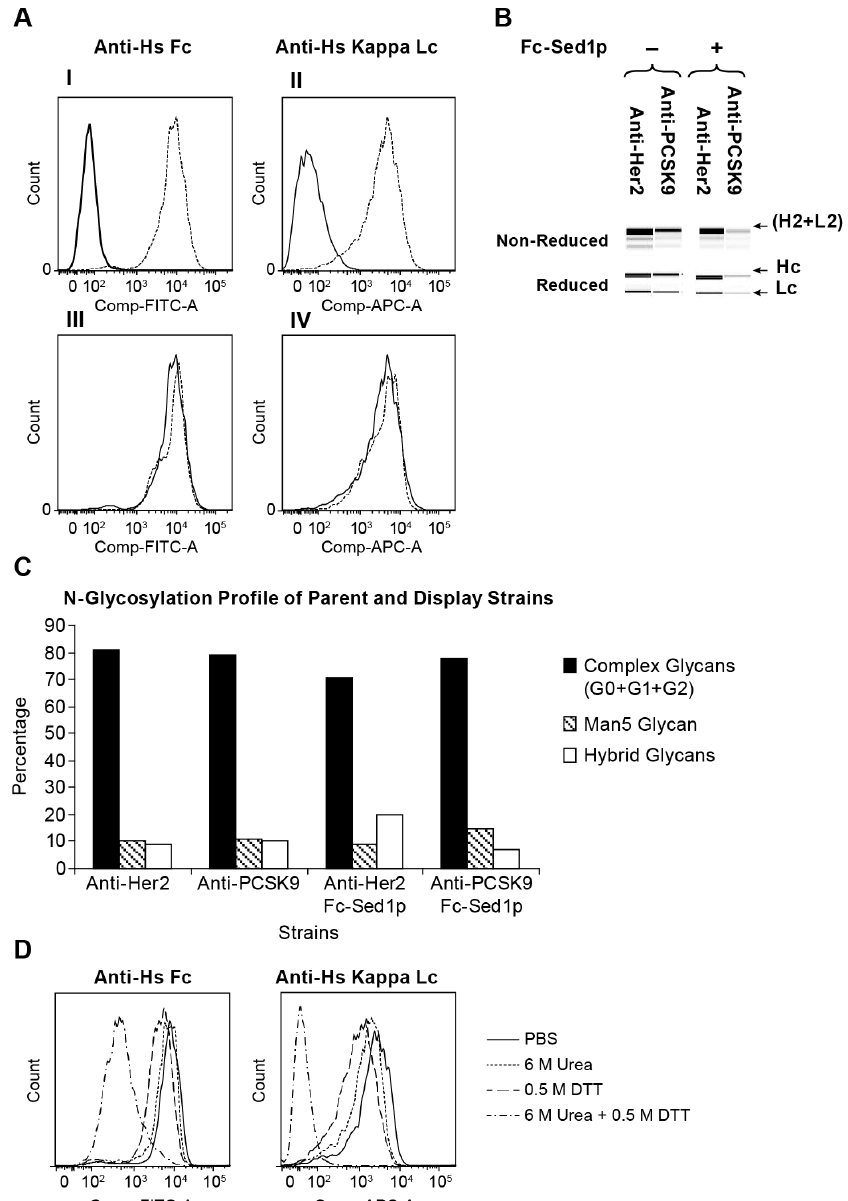
Figure 2. Efficiency of the surface anchored Fc bait (Fc-Sed1p) in capturing monovalent IgG molecules on the cell wall of Glyco-engineered Pichia pastoris . A ) (I) Strain expressing soluble anti-PCSK9 antibody (solid histogram) and anti-PCSK9 strain co-expressing Fc-Sed1p fusion (dotted) were incubated with DyeLight 488 anti-Fc antibody and florescence intensities were assayed by flow cytometry (II). Same strains as in (I) were incubated with APC-conjugated anti-Kappa antibodies to detect light chain on cell surface (III). Flow cytometry was used to compare strain co-expressing anti-PCSK9 and Fc-Sed1p anchor (solid) against strain co-expressing anti-Her2 and Fc-Sed1p (dotted) for binding to DyeLight 488 anti-Fc or (IV) APC-anti Kappa. B ) Detection of co-secreted full length IgG in antibody producing strains with and without Fc-Sed1p. Culture medium was passed through a protein A column, IgGs were eluted and protein was resolved in a native or reduced form through Protein Chip analysis C ) Bar graph of percentage human N-glycosylation abundances of protein A purified mAbs isolated in B. D) Cells co-expressing anti- PCSK9 and Fc-Sed1p fusion were induced and incubated for 10 minutes at room temperature in 1XPBS buffer (solid); 1XPBS buffer containing 6 M Urea (dotted); 1XPBS buffer containing 0.5 M DTT (dashed); or 1XPBS containing 6 M Urea and 0.5 M DTT (complex). Cells were washed and labeled with anti-human Fc (I) (DyeLight 488) and anti-human Kappa Lc (II) (APC). Fluorescence intensities were analyzed by flow cytometry. doi: 10.1371/journal.pone.0070190.g002 PLOS ONE |